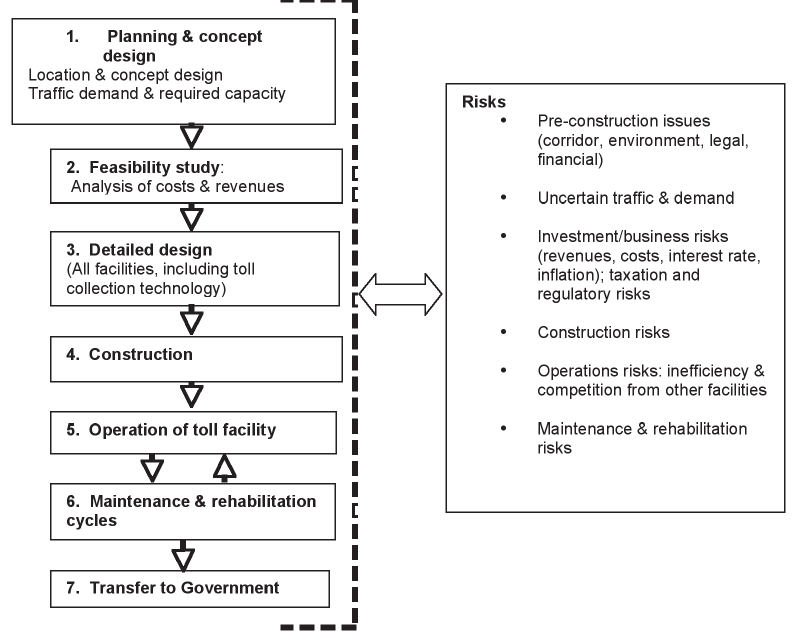
Figure 3: Toll roads planning process (Source: Khan